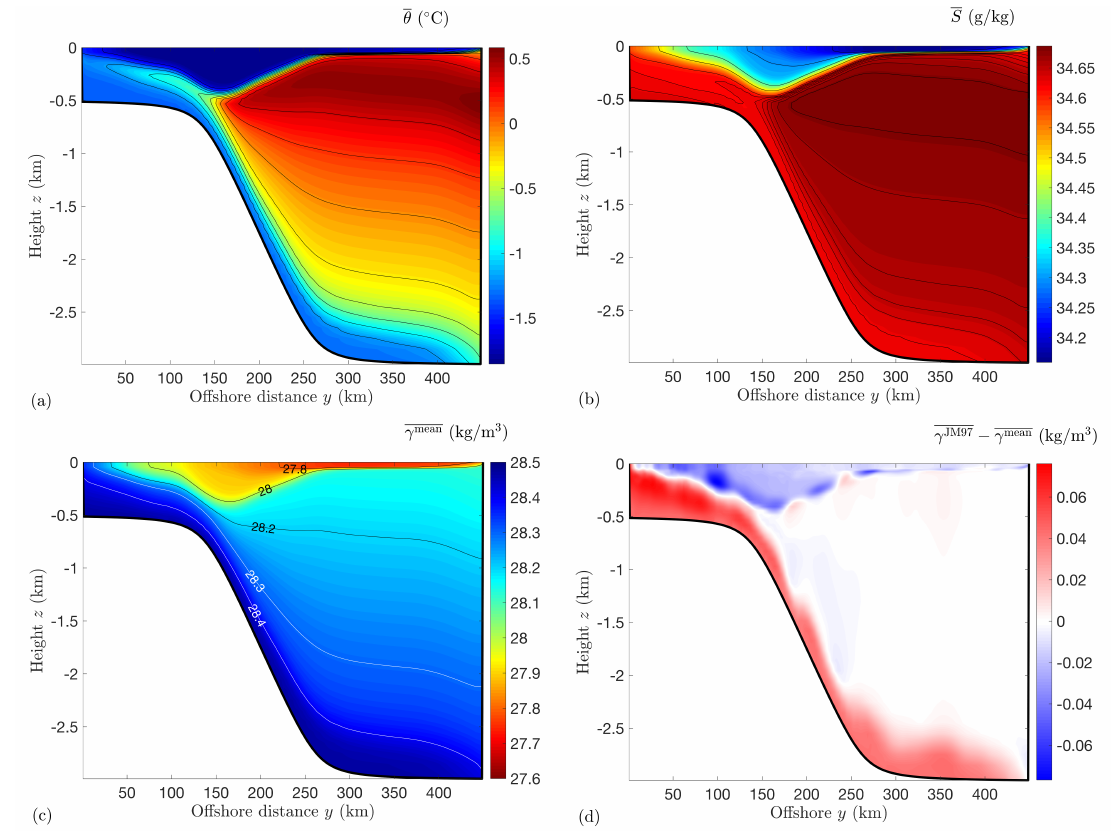
Figure 1. Diagnostics of the mean model state, where averages are taken in time (over 5 years of daily snapshots) and in the along-slope (zonal) direction (400km distance at ∼ 1km horizontal grid spacing. ( a ) Potential temperature θ , ( b ) practical salinity S , ( c ) Neutral Density constructed based